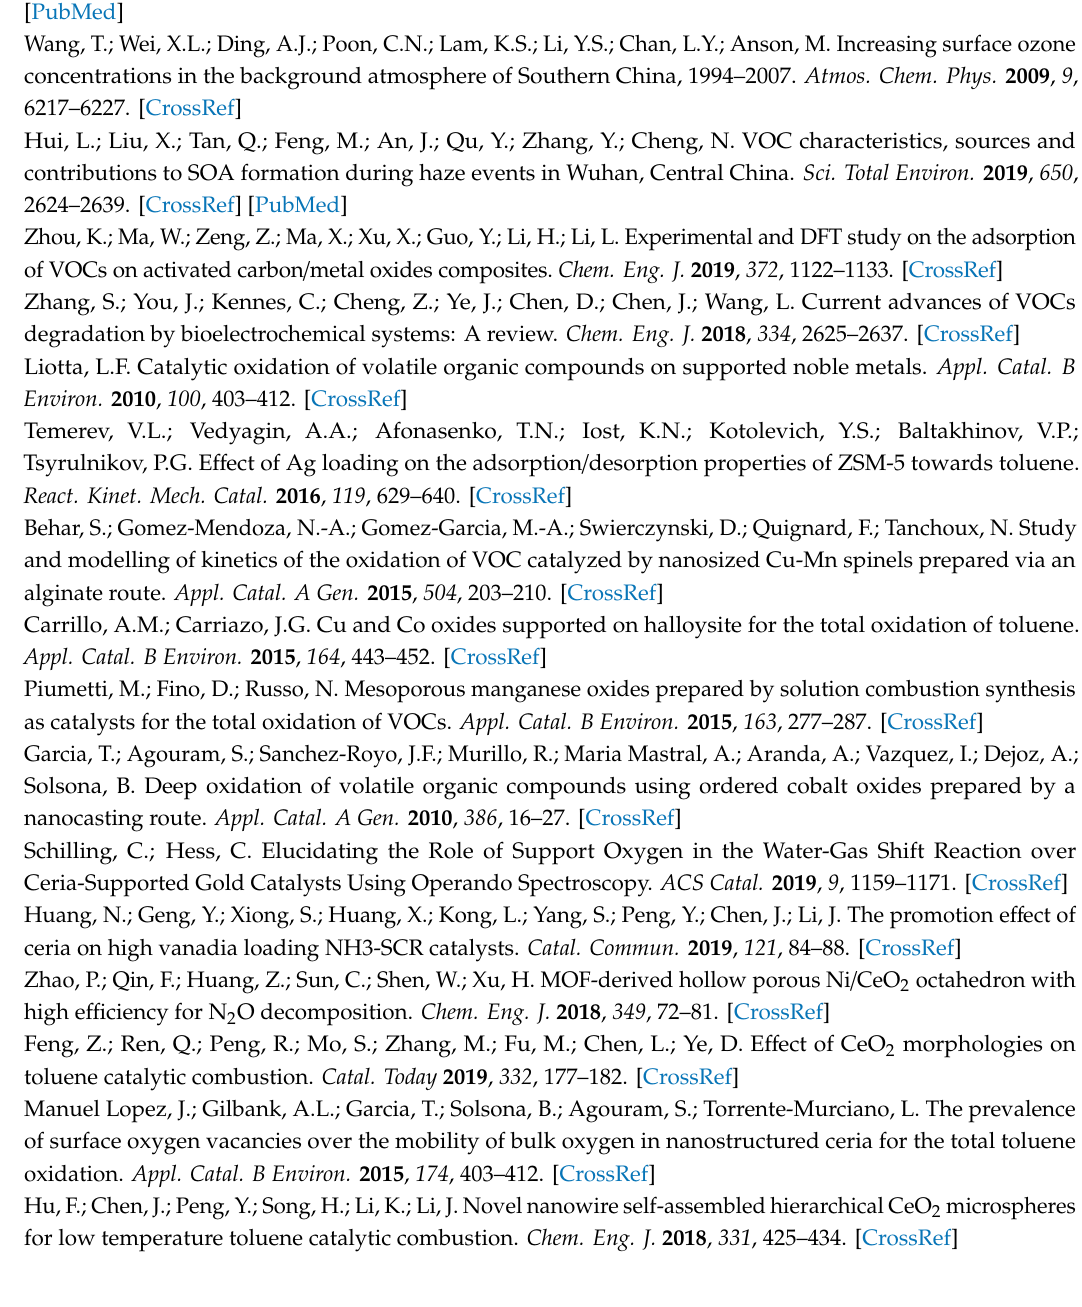
Figure S1: SEM images of Ce-MOF-808, Ce-BTC, and Ce-UiO-66 before calcination (a1, b1, c1), Ce-MOF-808-250, Ce-BTC-340 and Ce-UiO-66-320 after calcination at 250 ◦ C, 340 ◦ C, and 320 ◦ C, respectively (a2, b2, c2) and the corresponding final CeO 2 -MOFs after calcination at 500 ◦ C (a3, b3,